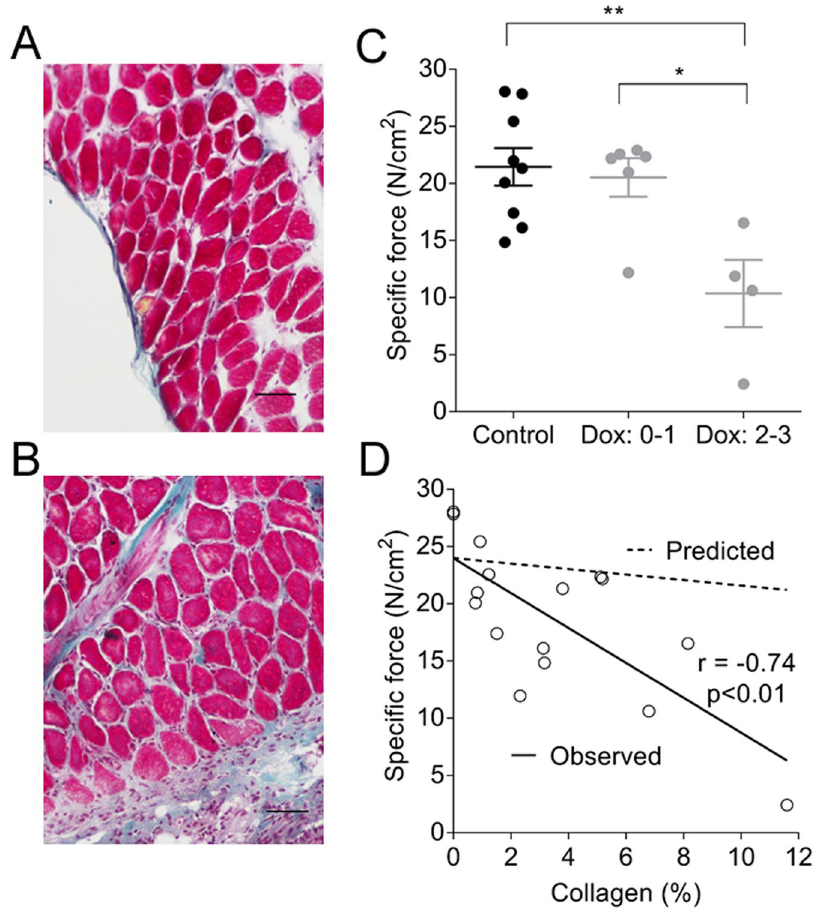
Figure 5. Cross sectional (scale bar = 0.1 mm) histological images of diaphragm from Control ( A ) and Dox groups ( B ). Blue collagen infiltration between muscle fibres and ligament thickening are apparent in the Dox group. Diaphragm maximum specific force ( C ) was reduced with more severe lung disease (fibrotic scores 2–3, ** p < 0.01, * p < 0.01). There was an inverse correlation between diaphragm collagen (%) and force ( D , n = 16). The predicted line shows the change in force that would be expected if muscle mass was replaced by collagen. Predicted force was calculated from the y -intercept of the observed line (24 N/cm 2 ) multiplied by the fraction of muscle (1-%collagen/100). Data are mean ±